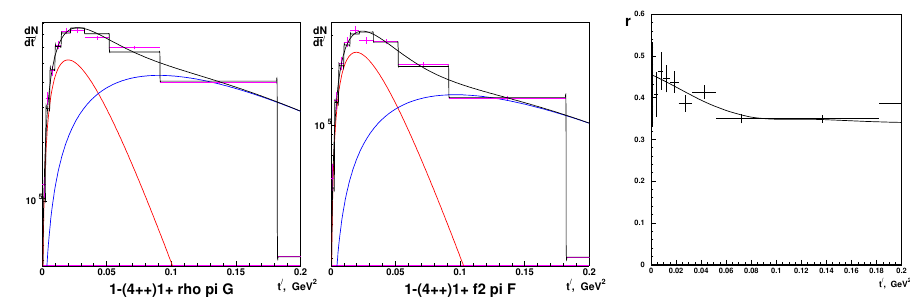
Figure 5. From left to right: distributions over | t (cid:3) | for the waves 4 + G 1 + ρ (770) π and 4 + F 1 + f 2 (1270) π , system π + 2 π − ; the ratio of these distributions. Step-like black curve represents mean values over bins for fitting function (continuous black curve); magenta crosses are PWA